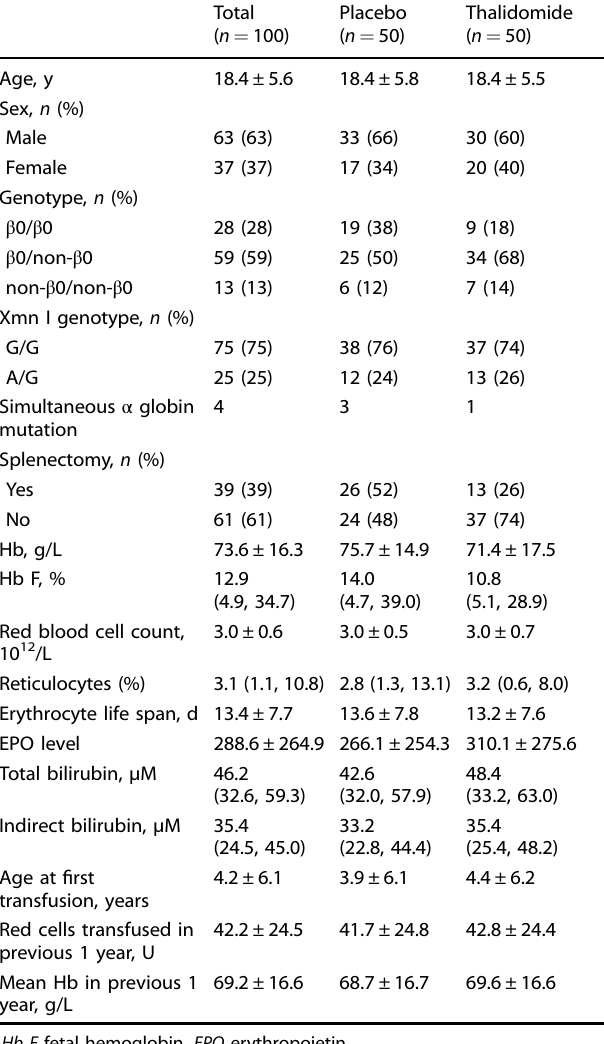
Table 1. Baseline demographic characteristics of the